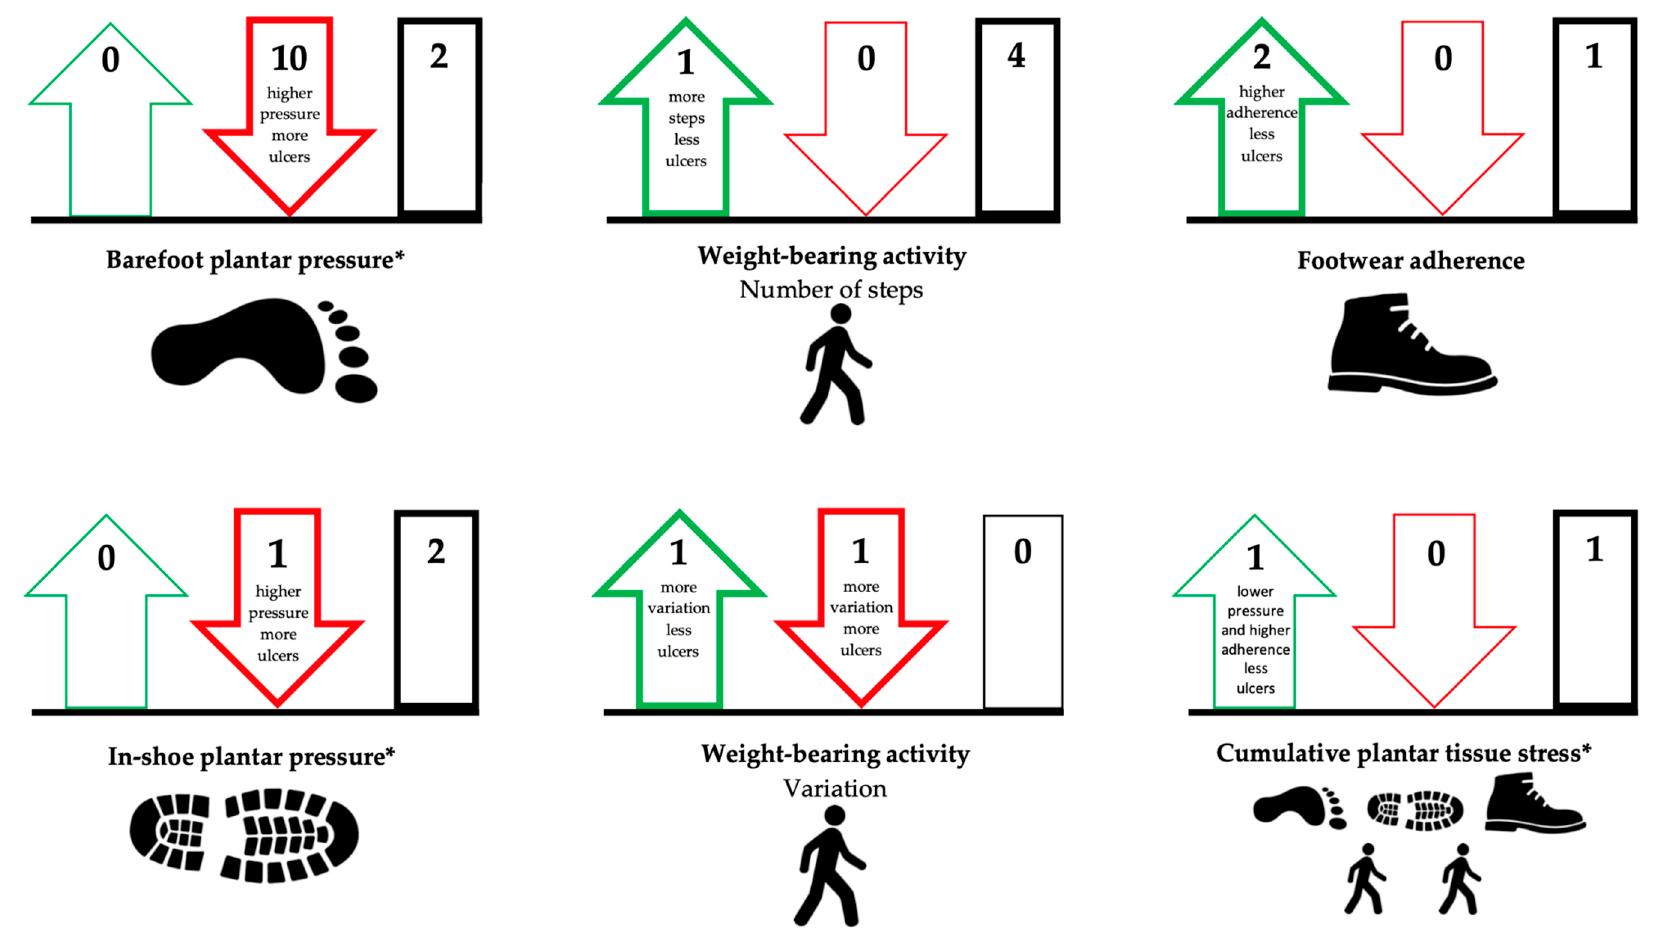
Figure 2. Overview of the results per foot-loading factor for ulcer development. Arrow up ( green ) = favorable association; arrow down ( red ) = unfavorable association; rectangle ( black ) = no association. Thick outline of arrow or rectangle means that there is evidence, thin outline means that there is no evidence. The number at the top in the arrow or rectangle is the number of studies found for the association in that direction. * Some publications investigated multiple associations, therefore the numbers in the figure do not always correspond to the number of included publications.